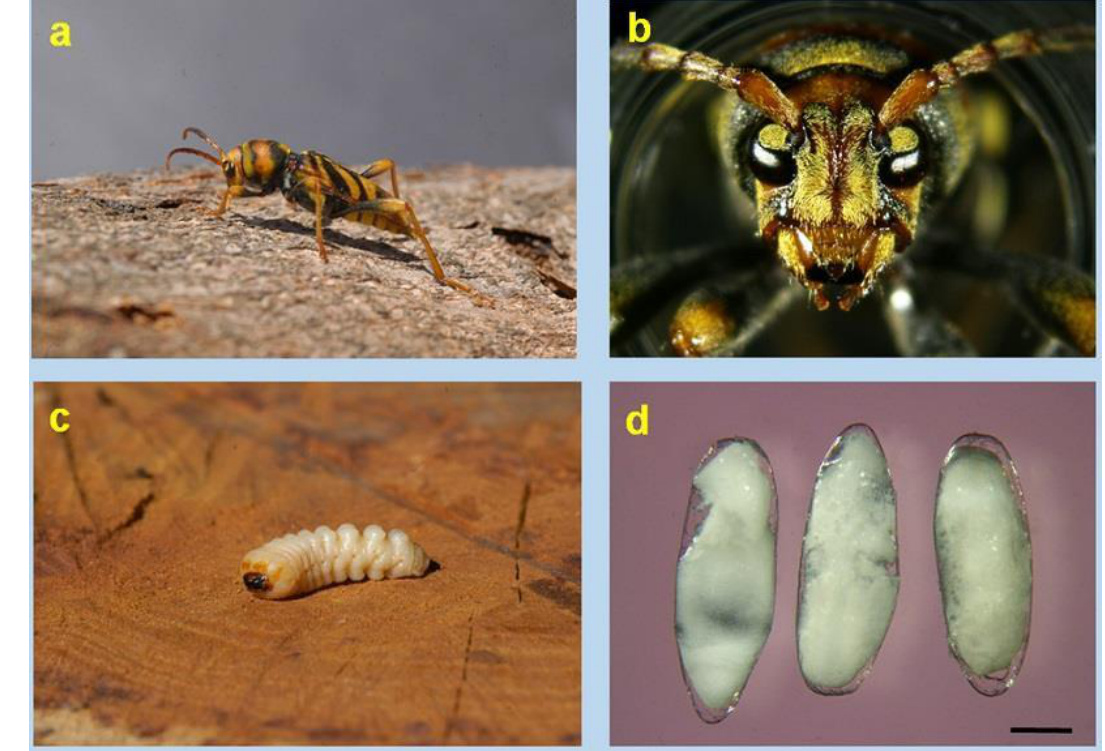
Figure 1. Xylotrechus chinensis life stages: ( a ) Female beetle walking on mulberry trunk; ( b ) Close-up of a beetle’s head, showing its widely separated antennae; ( c ) Last instar larva (extracted from its cavity); ( d ) Eggs (unfertilised), showing the oocyte mass protected by a transparent flexible chorion. Scale bar 0.5 mm. The pupa is not photographed. (Photos V. Sarto i Monteys).